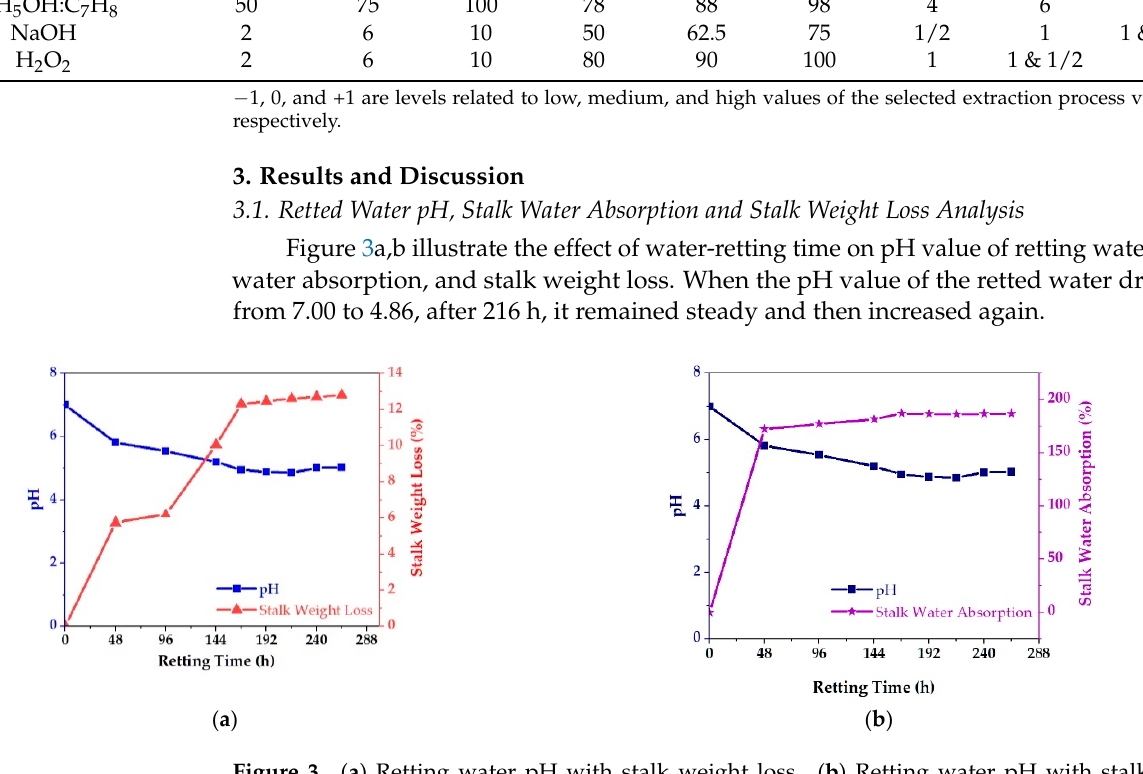
Figure 3. ( a ) Retting water pH with stalk weight loss. ( b ) Retting water pH with stalk water absorption at different retting times.